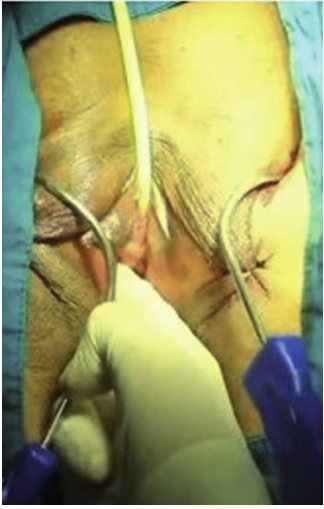
Figure 4 - A 0.5cm cut is made, and needle points are taken